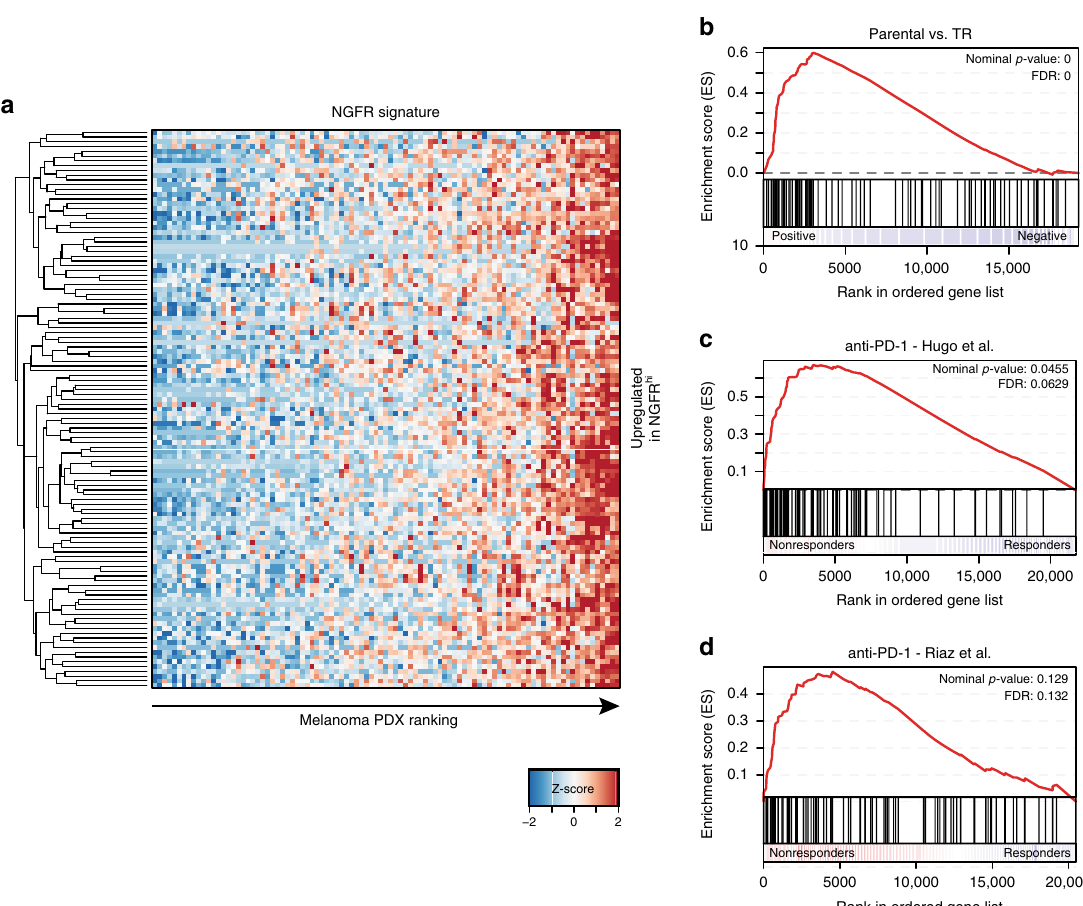
Fig. 4 NGFR predicts immunotherapy resistance in melanoma patients. a Heat map of the NGFR signature on a cohort of n = 95 melanoma PDX. b Gene Set Enrichment Analysis (GSEA) of NGFR signature ( “ upregulated in NGFR hi ” ) on three parental vs. TR cell lines. c , d GSEA on two clinical datasets of patients treated with anti-PD-1 therapy. References for the source data of these databases can be found in the Methods